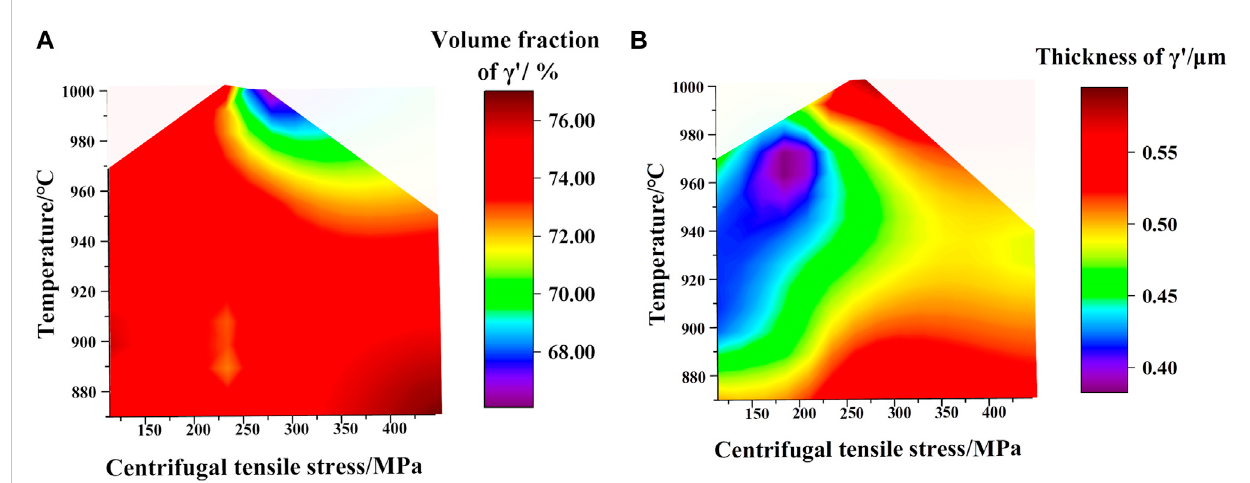
FIGURE 5 Coupling effects of stress and temperature on the con fi guration of γ ′ precipitates in the serviced DZ125 blade. Dependence of (A) the volume fraction and (B) the thickness of γ ′ precipitates on temperature and